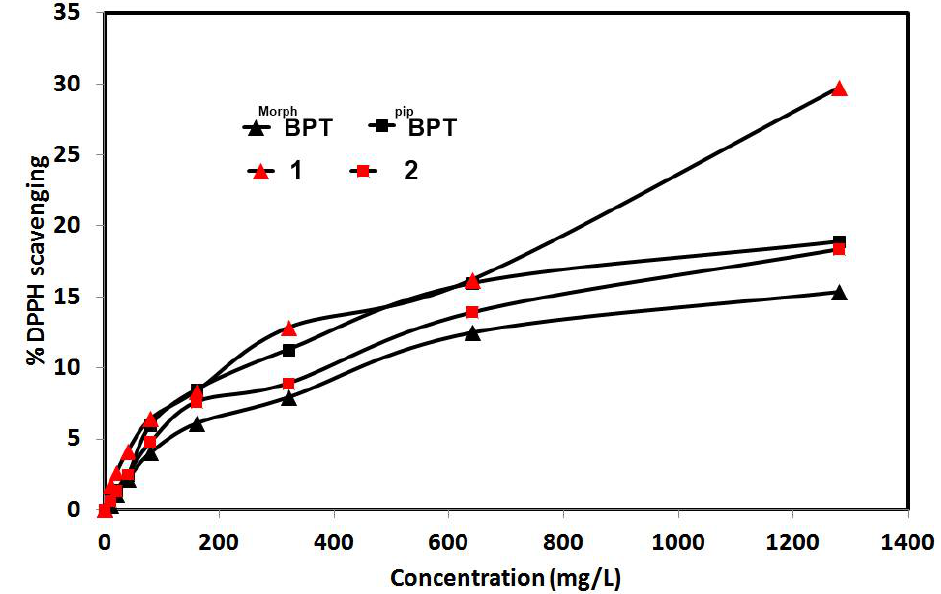
Figure 12. The antioxidant activity of the studied compounds.